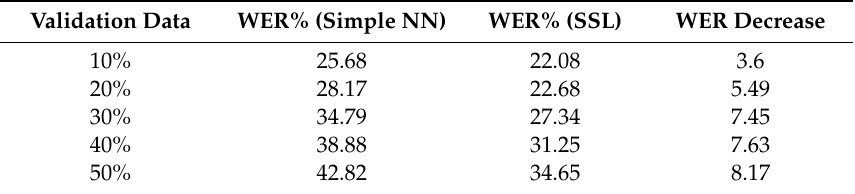
Table 10. Decrease in WER after incorporating Semi-Supervised Learning (SSL) and regularization